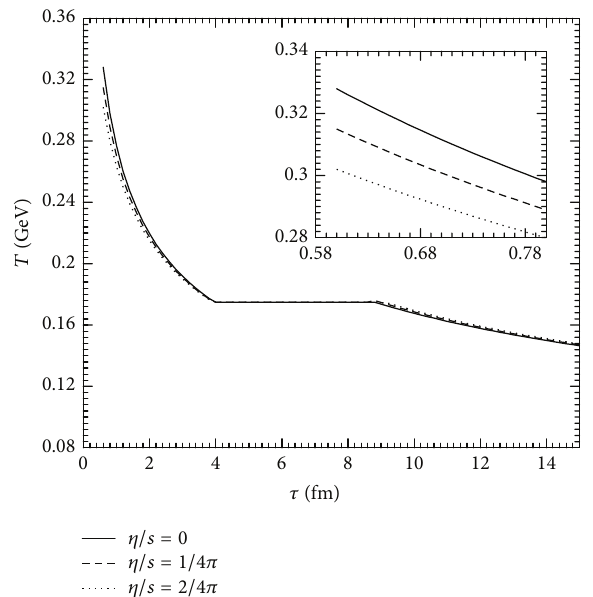
Figure 10: Variation of temperature with proper time for different phases for various values of the shear viscosities. Inset shows the effect of viscosity on the cooling of the QGP phase (in an amplified scale) for different values of 𝜂/𝑠 .